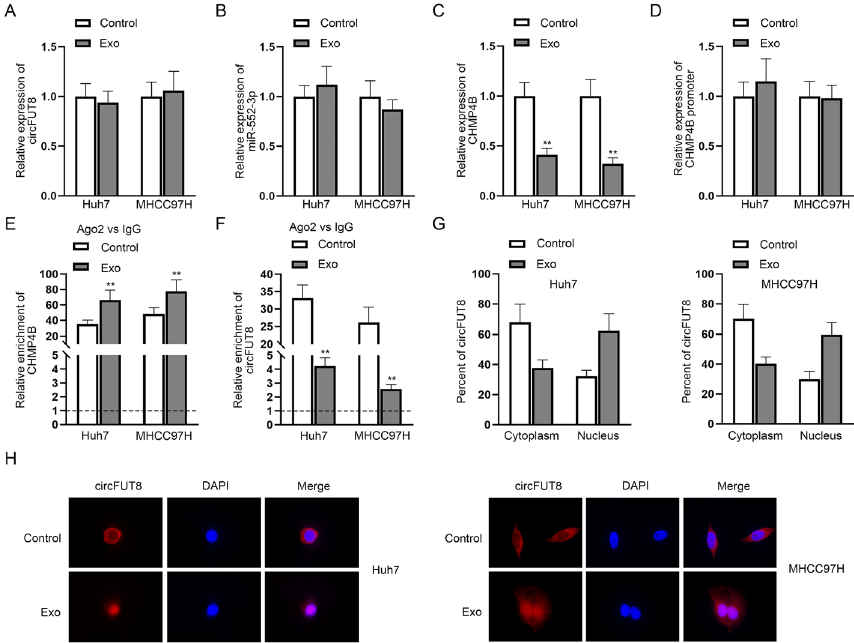
Fig. 4 M1 macrophages-derived exosomes inhibited the nuclear export of circFUT8. A – C CircFUT8, miR-552-3p, and CHMP4B expression in HCC cells treated with M1-Exo or control was tested via RT–qPCR. D The effect of M1-Exo on the luciferase activity of CHMP4B promoter region in HCC cells. E , F RIP assay was adopted to assess CHMP4B and circFUT8 enrichment after HCC cells were treated with M1-Exo. G , H CircFUT8 distribution in HCC cells treated with M1-Exo or control was determined by nucleus–cytoplasmic separation and FISH assays. In C and B , data in the experimental group had statistical significance, with P <